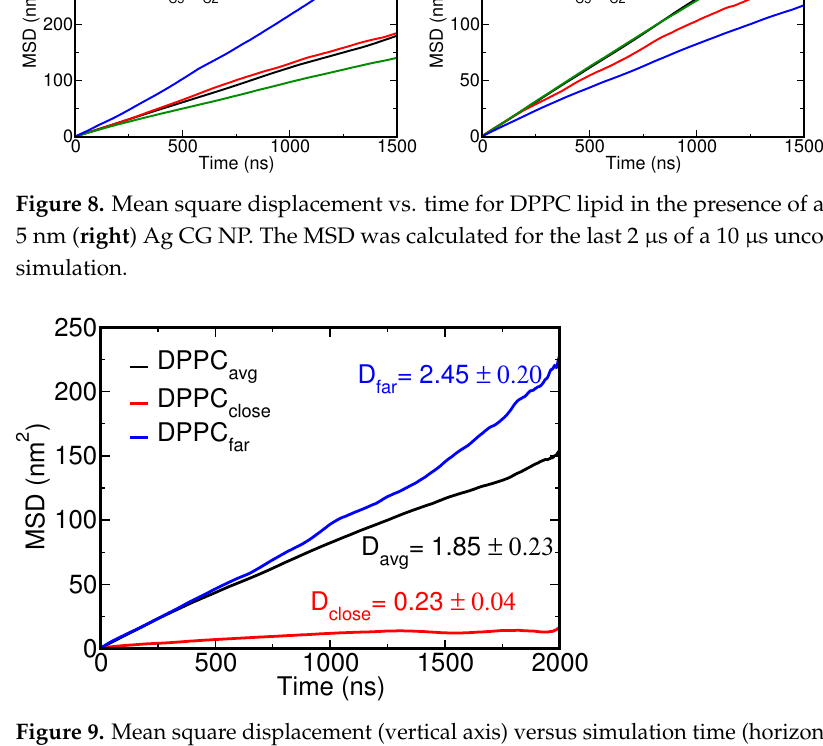
Figure 9. Mean square displacement (vertical axis) versus simulation time (horizontal axis) for DPPC in the presence of a 5 nm Ag CG NP. Here, DPPC avg (black) refers to the average displacement of DPPC lipids—see also Table 1—DPPC far (blue) refers to DPPC molecules that remain far/unbound from the NP during simulation and DPPC close (red) refers to lipids that become entrapped/bound by the CG NP. The corresponding diffusion constants (in units of × 10 − 7 cm 2 s − 1 ) calculated from the MSD are added in matching colors. Diffusion rates for (un)bound lipids were determined from the last 2 µ s of a 10 µ s CGMD production run. Lipids in either pool, i.e., 25 bound or unbound lipids in total, were randomly selected from the two